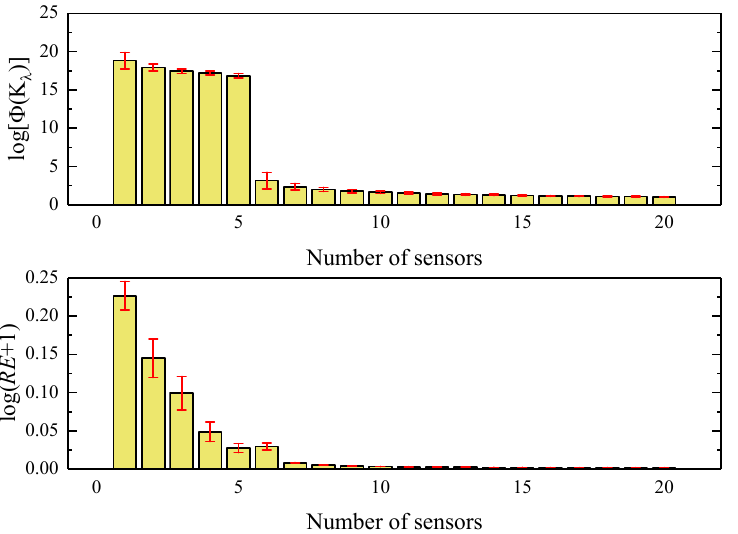
Figure 17. The average and variance (red bars) over 1000 trials of logarithm of the condition number of K λ and relative errors (velocity field).